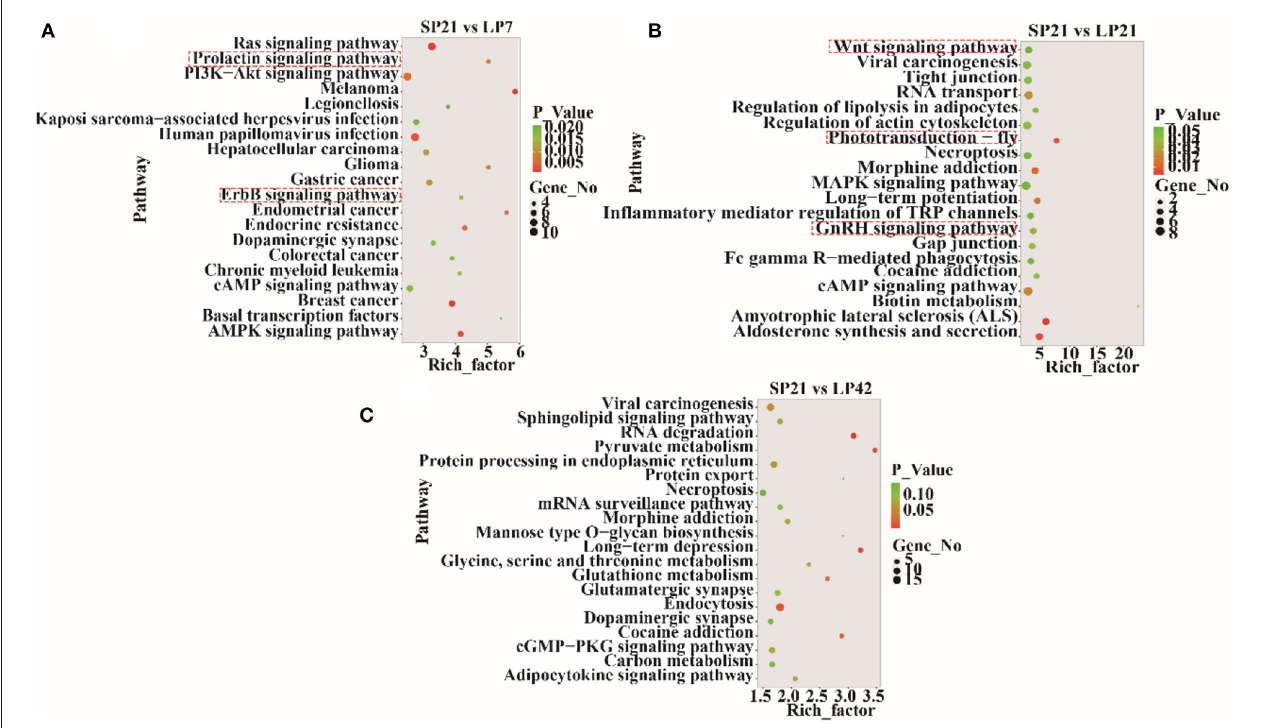
FIGURE 5 | KEGG pathway analysis for target genes of differentially expressed lncRNAs between short photoperiod and long photoperiod in PT of Sunite sheep. (A) Top 20 enrichment pathways in SP21 vs. LP7. (B) Top 20 enrichment pathways in SP21 vs. LP21. (C) Top 20 enrichment pathways in SP21 vs. LP42. Rich_factor is defined as the amount of differentially expressed genes enriched in the pathway/amount of all genes in the background gene set. The red boxes represent the seasonal reproduction-related